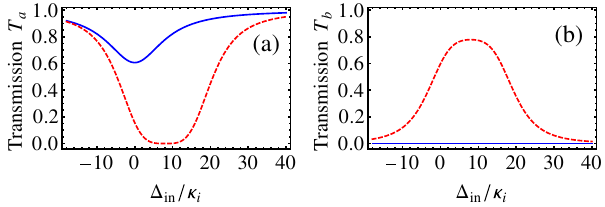
and T as a function of a b ; i